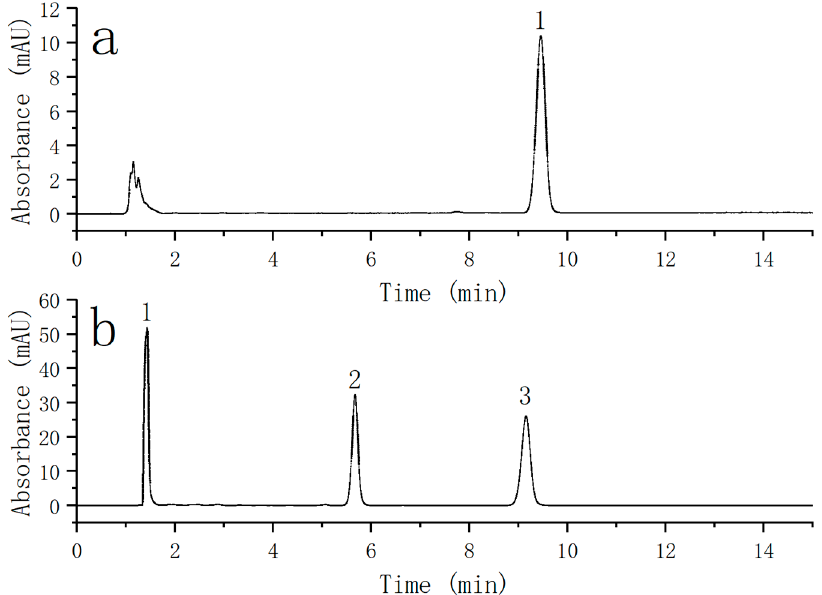
Figure 14. ( a ) Chromatographic separation diagram of naphthalene (1); ( b ) chromatographic separation diagram of uracil (1), ortho-terphenyl (2), and chrysene (3).